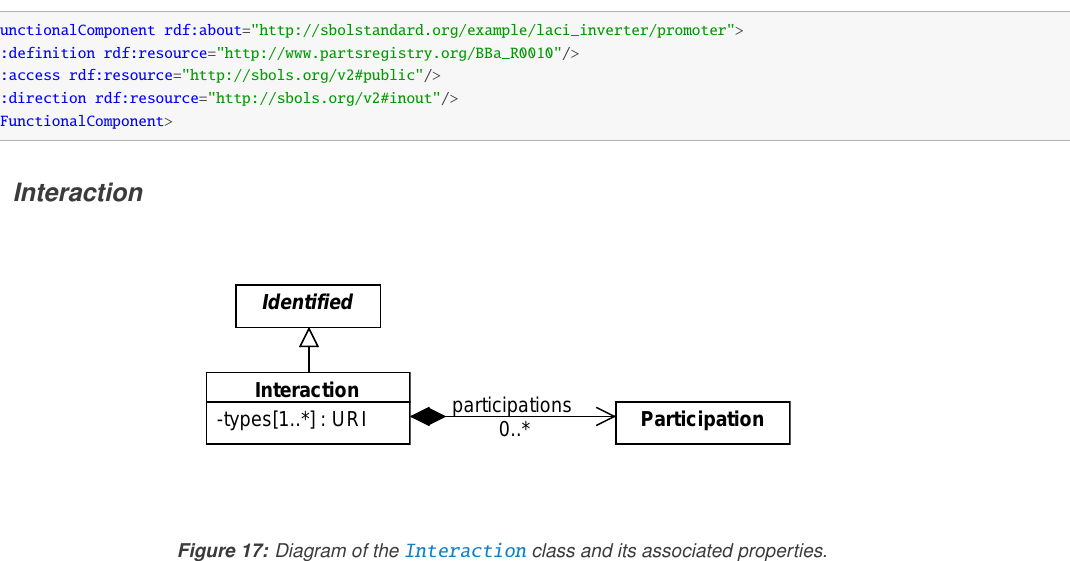
Figure 17: Diagram of the Interaction class and its associated